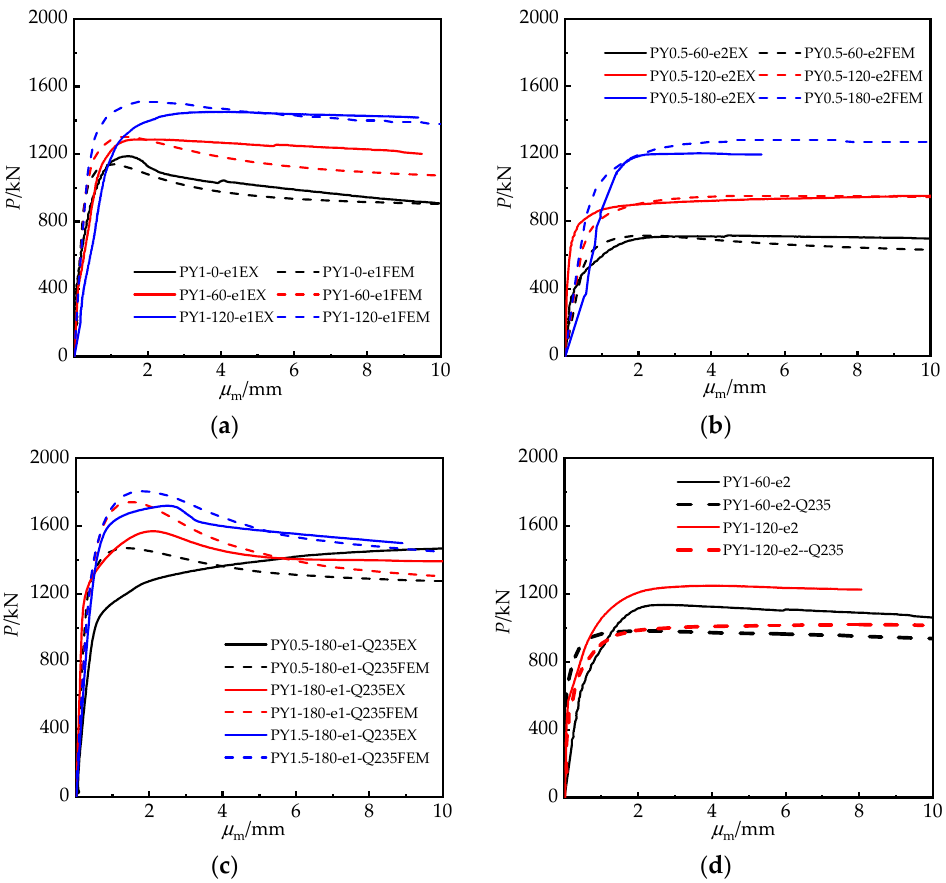
Figure 8. Axial load vs. mid-length lateral displacement curves: ( a ) κ =1, with different θ ; ( b ) κ =0.5, with different θ ; ( c ) θ =180°, with different θ ; ( d ) Different f y .